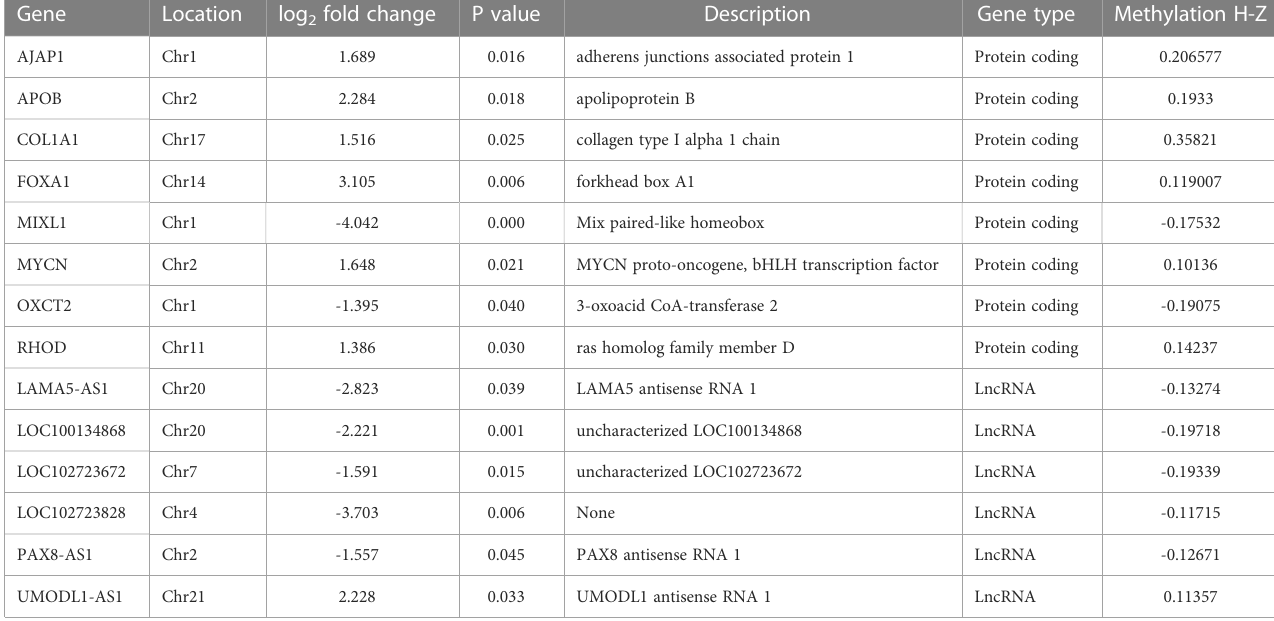
TABLE 3 Overlapped genes of DEGs and promoter related DMR genes.